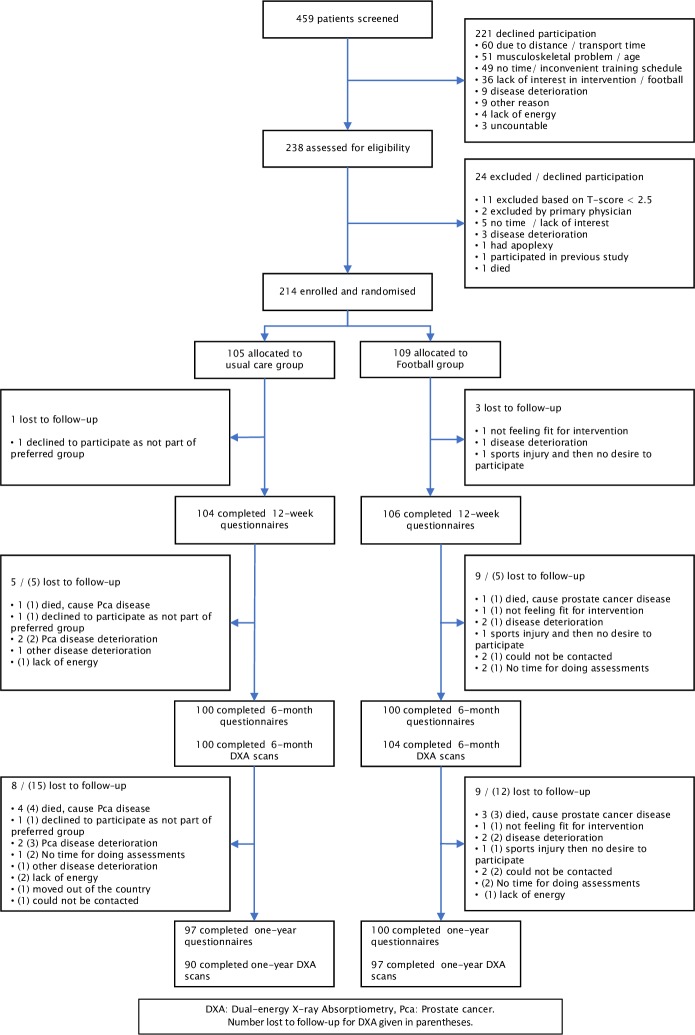
CONSORT 2010 flow diagram.